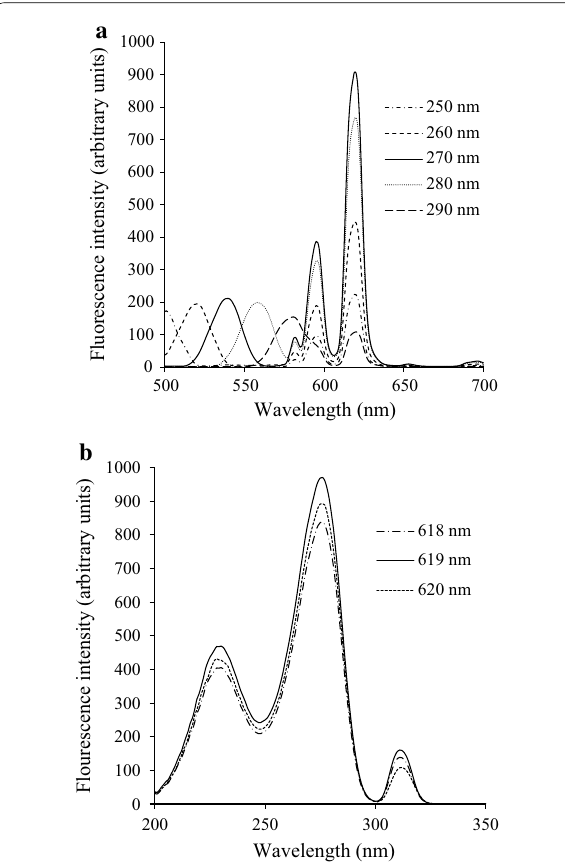
Fig. 2 Emission ( a ) and excitation ( b ) fluorescence spectra of DPA‑Eu‑CyDTA with the DPA final concentration of 400 nM